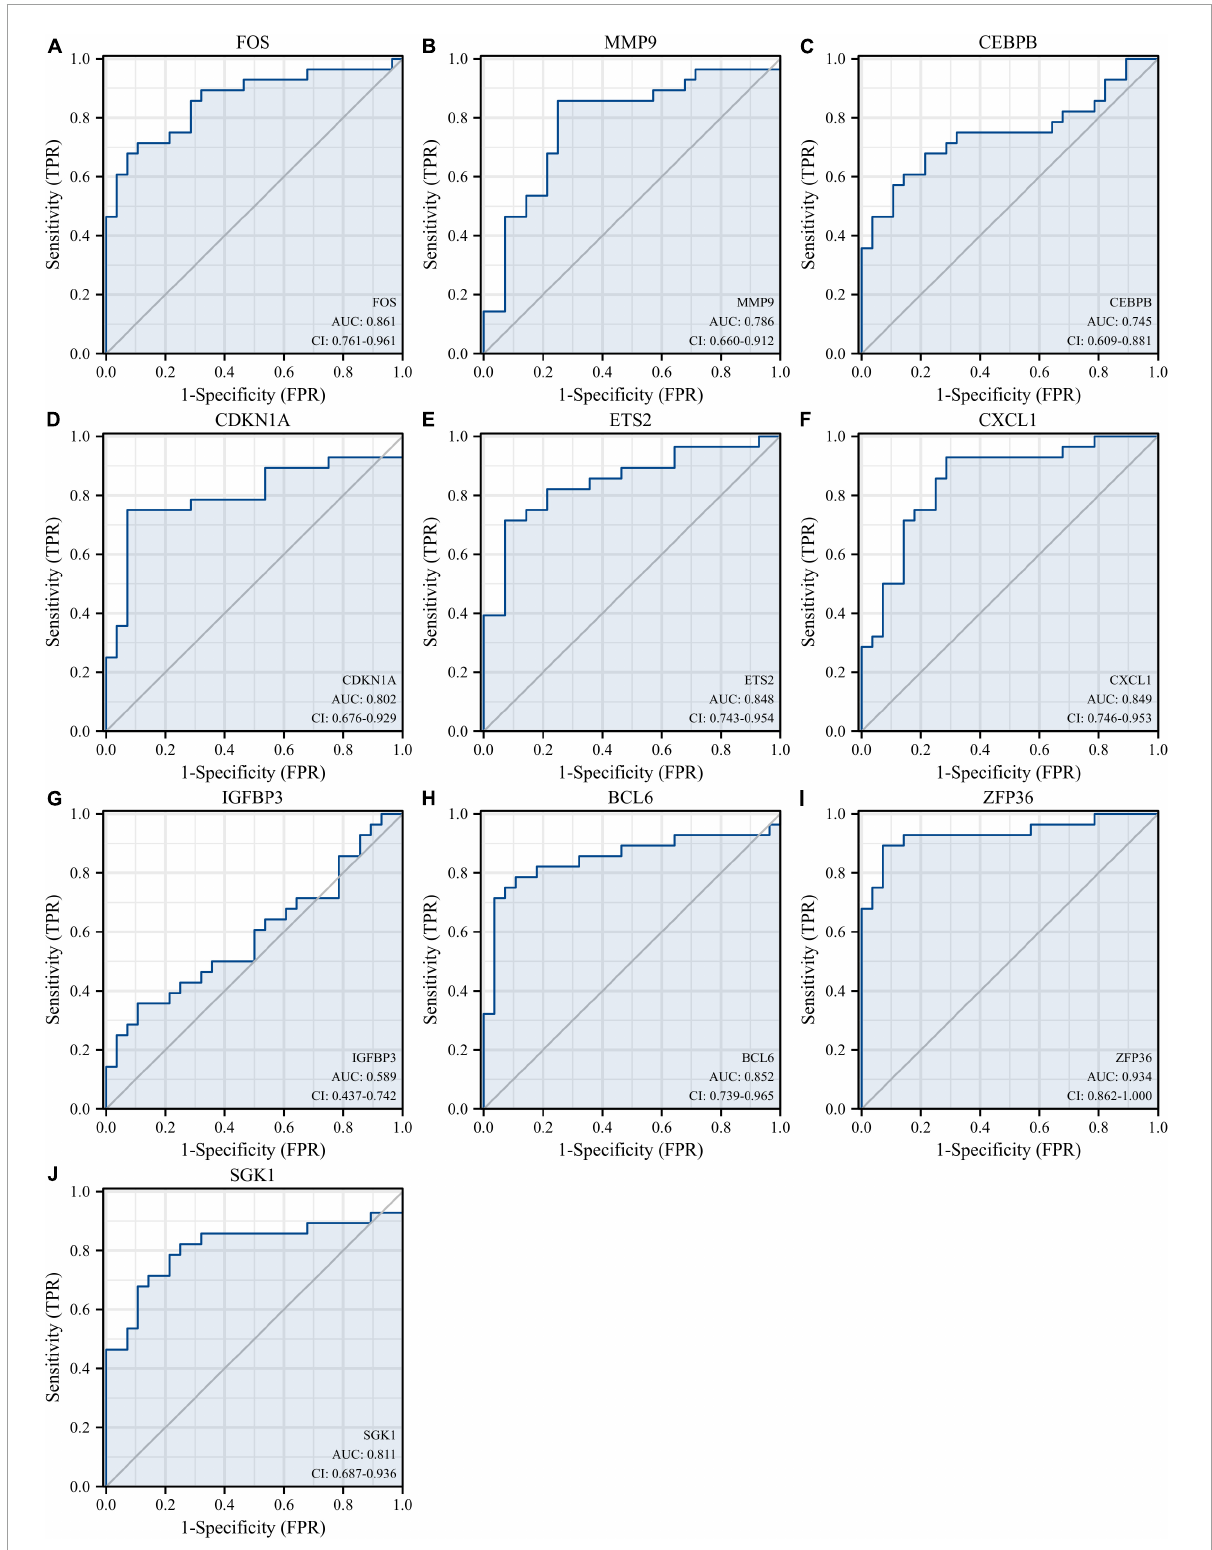
FIGURE10 Diagnostic values of 10 hub genes in the GSE66360 validation set. ROC curves of FOS (A) , MMP9 (B) , CEBPB (C) , CDKN1A (D) , ETS2 (E) , CXCL1 (F) , IGFBP3 (G) , BCL6 (H) , ZFP36 (I) , and SGK1 (J) . ROC, receiver operating characteristic.